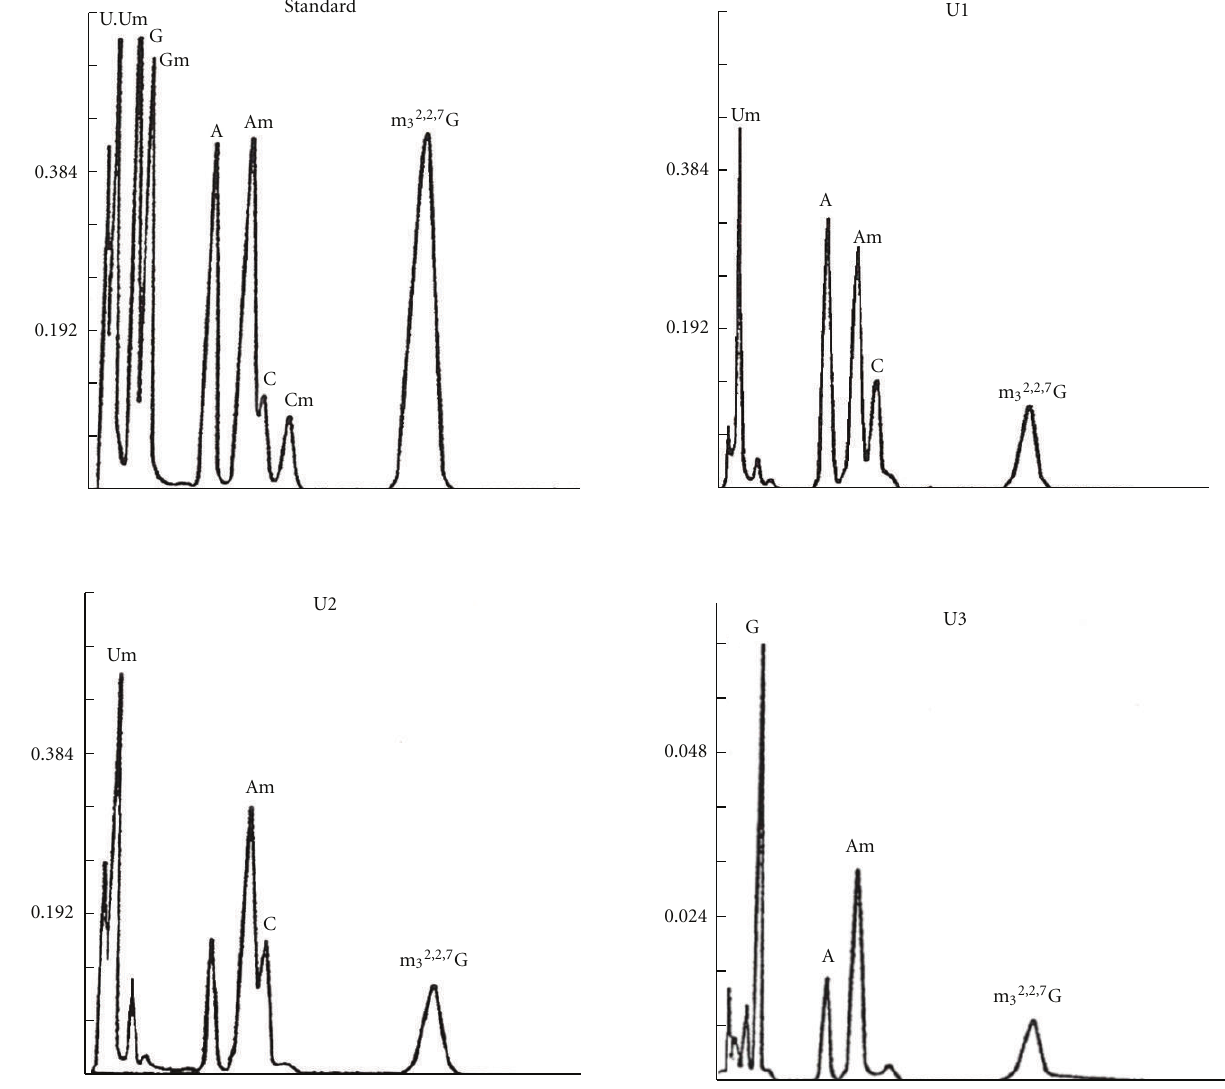
Figure 18: HPLC (High Pressure Liquid Chromatography) pattern of nucleosides of 5 (cid:2) oligonucleotides of U1 RNA, U2 RNA, and U3 RNA [37]. The 5 (cid:2) oligonucleotides of U1, U2, and U3 RNAs were obtained by digestion of T 1 RNase and RNase A. The fragments were digested with snake venom phosphodiesterase and alkaline phosphatase. The nucleosides produced were separated by high pressure liquid chromatography (Varian Aerograph Liquid Chromatograph LCS-1000) at 55 ◦ C, 700–800 p.s.i. with 0.4M ammonium formate (pH 3.5). Absorbance at 254nm was